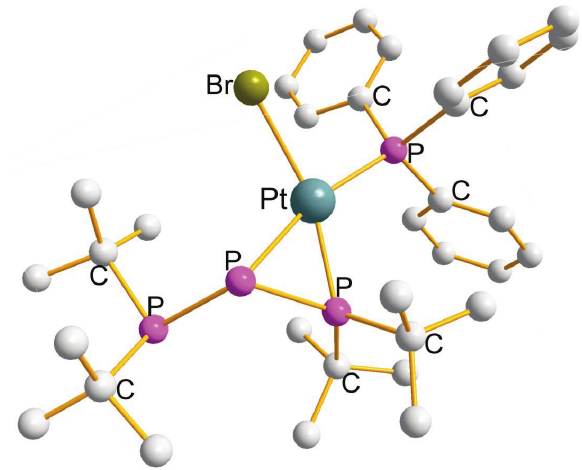
Figure 8: Structure of [Pt{η 3 -Ph (Pan et al.,